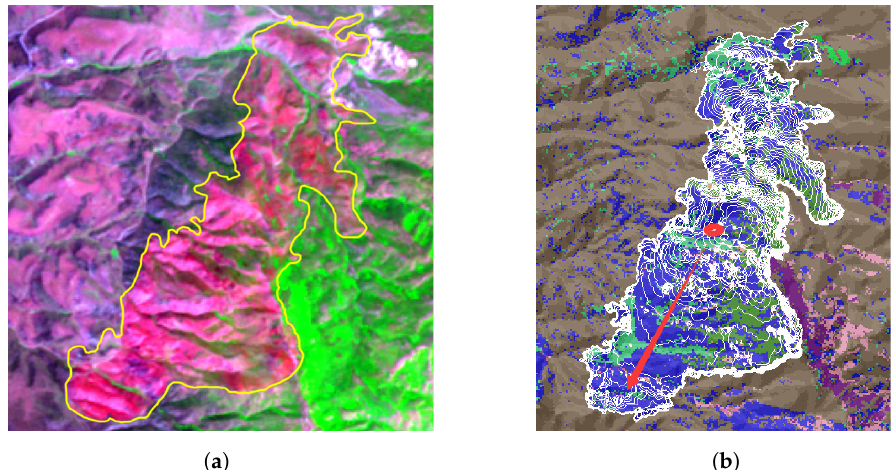
( a ) ( b ) Figure 15. Comparison between the actual combustion area and simulation region of Emery wildfire. ( a ) The actual combustion area. ( b ) The result of